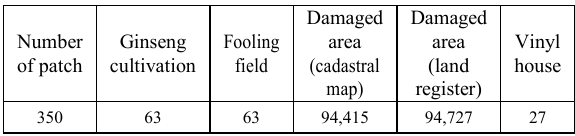
Table 2 . Results of damage to ginseng cultivation field